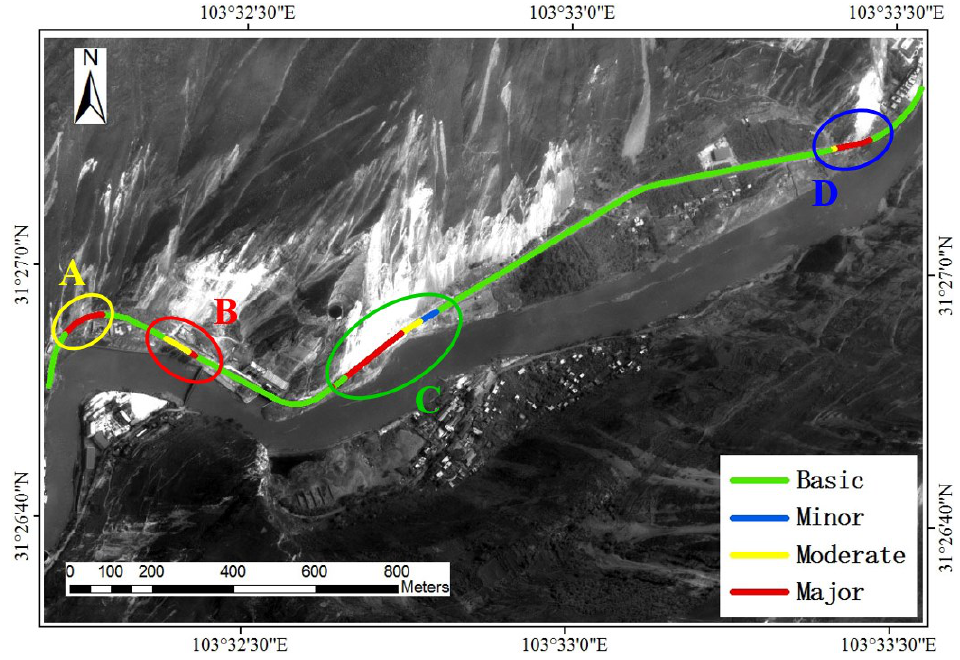
Figure 13. Result of damage grade identification. The damage grades of the green, blue, yellow and red road segments are basic, minor, moderate and major,